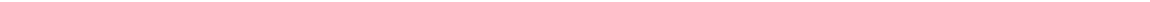
Fig. 4 Using LFP power to characterize the functional impact of population synchrony. a Example time-frequency spectrogram for a desynchronized trial averaged across all recording electrodes. The power ratio for this trial was 0.799 (P 2 – 10Hz /P 10-70Hz ). b Example time-frequency spectrogram for a synchronized trial averaged across all recording electrodes. The power ratio for this trial was 3.273 (P 2 – 10Hz /P 10-70Hz ). c Z -scored LFP power in synchronized and desynchronized cortical states (de fi ned by PSI). LFP power was calculated using a 5 Hz rolling window size with a step of 1 Hz. Shaded areas represent standard error. d Z -scored LFP power in physiologic bands for synchronized and desynchronized trials (as de fi ned by PSI) ( Δ = 2 – 4 Hz, θ = 4 – 8 Hz, α = 8 – 12 Hz, β = 12 – 30 Hz, γ = 30 – 100 Hz) (*** P < 0.0001, ** P < 0.005). e Black dots: scatter plot of behavioral performance (% correct responses) in desynchronized/synchronized cortical states (de fi ned by the LFP power ratio). Each point represents one session. Gray circles: scatter plot of behavioral performance in desynchronized/synchronized cortical states. Trials were selected only if they shared the same state of synchrony using both the PSI and the power ratio methods. f Difference in average behavioral performance (% correct responses) between synchronized and desynchronized states was higher when cortical state was assessed using both the PSI and power ratio methods (* P < 0.01; ** P < 0.0005). The red line connects the mean of each category. g Example session showing z -scored pupil size as a function of PSI for all trials (all measurements were performed during the delay period). There was no signi fi cant correlation between the two variables ( r = − 0.04, P = 0.5283, Pearson correlation). h Across sessions, the mean pupil diameter in the synchronized state was not signi fi cantly different than the mean pupil diameter in the synchronized state ( P = 0.5124, paired t